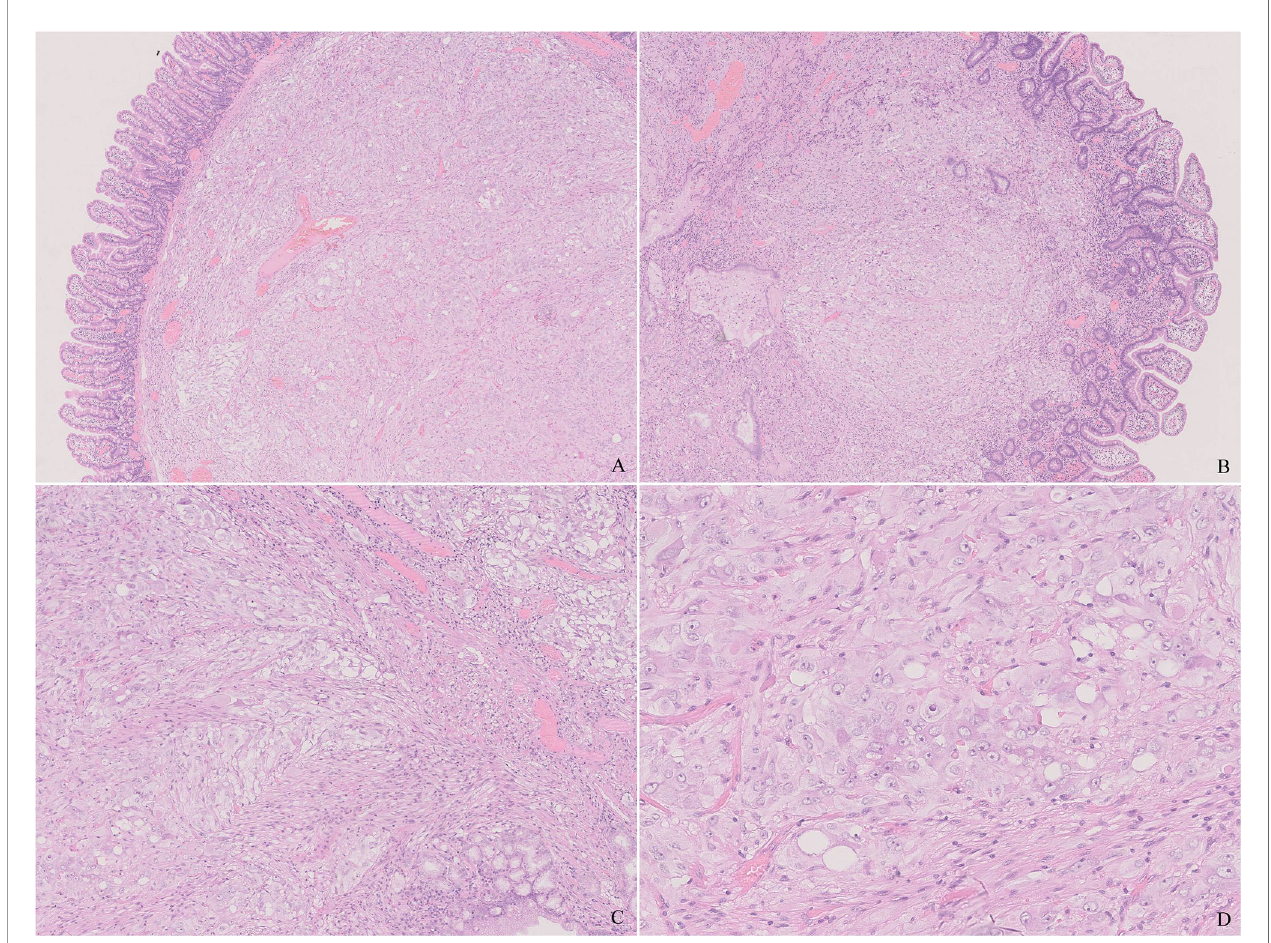
FIGURE 2 | Histology of the tumor. (A) The tumor was well-circumscribed and non-encapsulated and located in the submucosa. (B) The tumor in fi ltrated the lamina propria focally. (C) The tumor was composed of epithelioid, ganglion-like, and spindle cells. Note the muscularis mucosae in the upper right that are different from the neoplastic spindle cells. (D) The epithelioid cells have abundant eosinophilic cytoplasm and a round nucleus. Note a ganglion-like cell in the center, which was larger in shape, and a nucleus with prominent eccentric nuclei. [ (A, B) , H&E ×20, (C) , H&E ×100, (D) , H&E